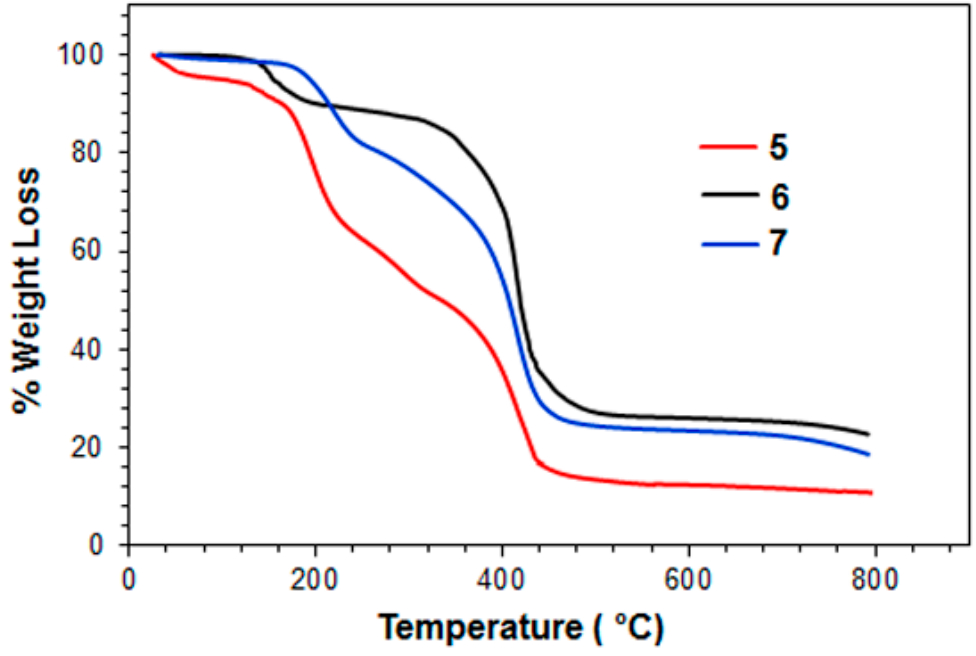
Figure 2. TGA curves for the corrosion inhibitors 5 , 6 , and 7 .